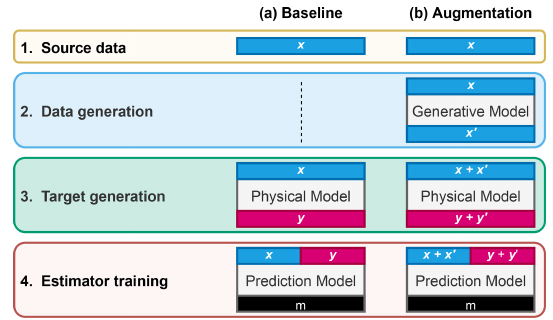
Figure 1. General strategies identified for training ML emulators. (a) Inputs x are fed to the physical model to generate correspond- ing outputs y ; x and y are used to train the ML emulator. (b) A data generation model (here copula) is fitted to inputs x to generate synthetic inputs x (cid:48) ; inputs x and x (cid:48) are fed to the physical model to generate corresponding outputs y and y (cid:48) ; both x , x (cid:48) and y , y (cid:48) are used to train the ML emulator. After training, the model ( m ; e.g. architecture and weights) is saved and used for inference on new